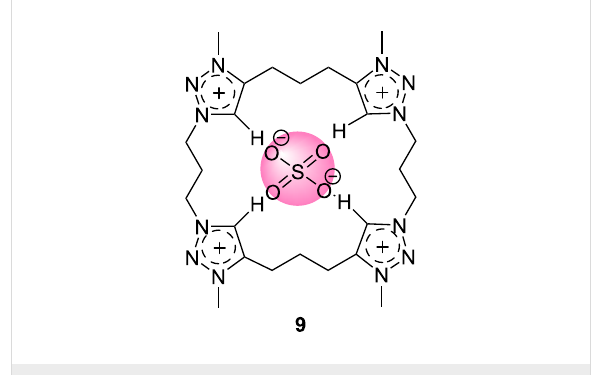
Figure 9: Chemical structures of compound 9